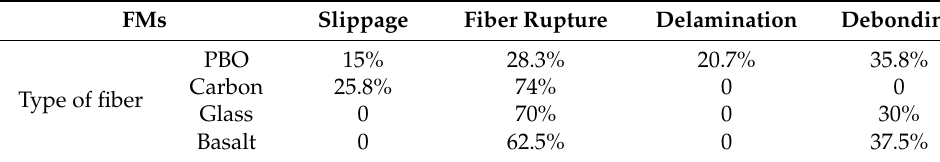
Table 16. The percentage of composite type in the strengthened